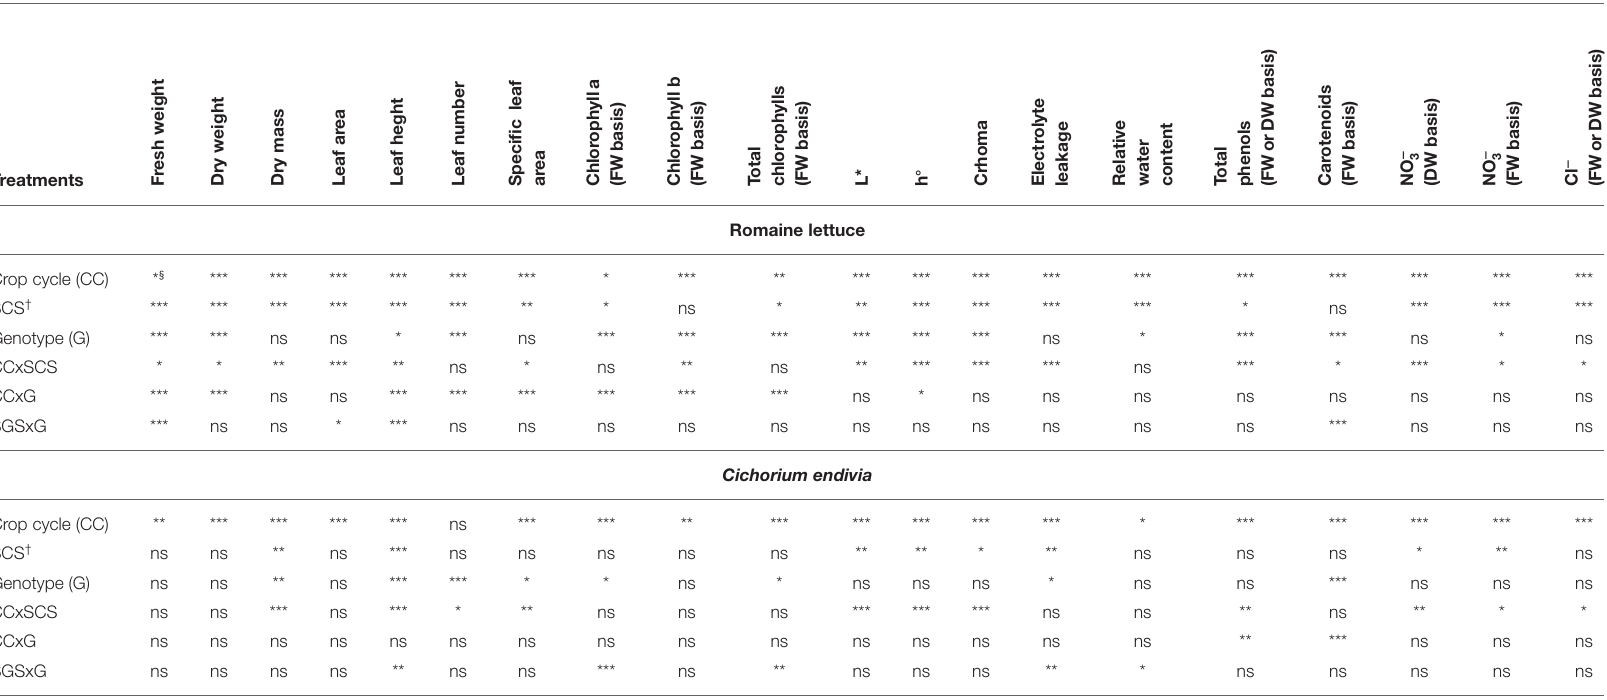
TABLE 8 | The significance of F test of ANOVA for the effects of the crop cycle (CC), soilless cultivation system (SCS), and genotype (G), and their interactions, on yield, bio-morpho-physiological traits, nitrate, chloride and antioxidant compound concentration in romaine lettuce and C. endivia .